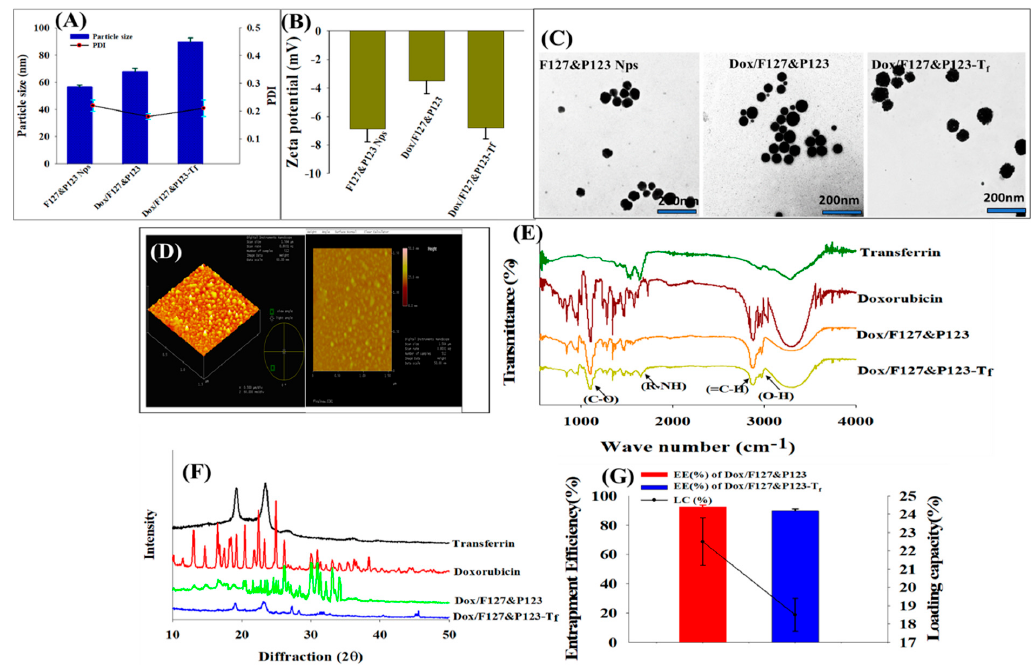
Figure 2. ( A ) Particle sizes and polydispersity indexes (PDIs), ( B ) zeta potentials, and ( C ) TEM images of F127&P123 NPs, Dox/F127&P123, and Dox/F127&P123-T f ; ( D ) AFM images of Dox/F127&P123-T f ; ( E ) FTIR spectra, and ( F ) X-ray diffraction patterns of Dox, T f , Dox/F127&P123, and Dox/F127&P123-T f ; ( G ) entrapment efficiency (EE) and loading capacity (LC) of Dox in Dox/F127&P123, and Dox/F127&P123-T f .